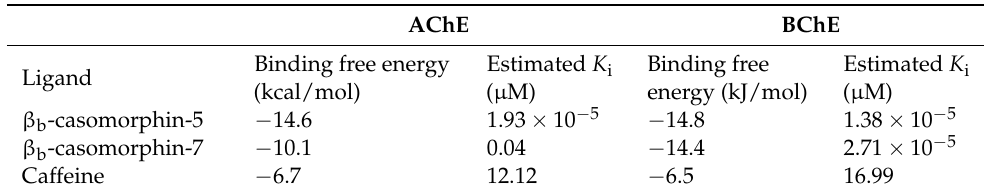
Table 3. Binding free energy of compounds to AChE (PDB: 2 × 8B) and BChE (PDB: 4BBZ) calculated by molecular docking, as well as computational dissociation constant.